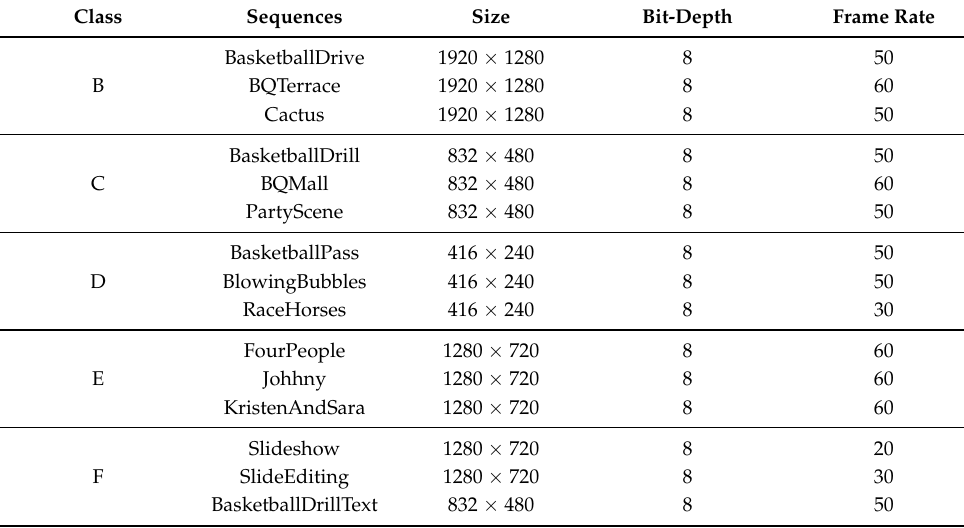
Table 5. Detailed characteristics of the experimental video